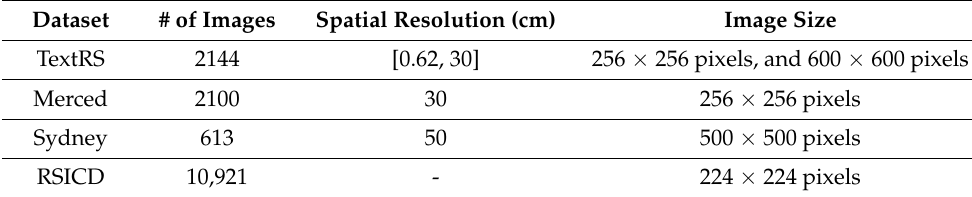
Table 2. Characteristics of the text–image retrieval RS